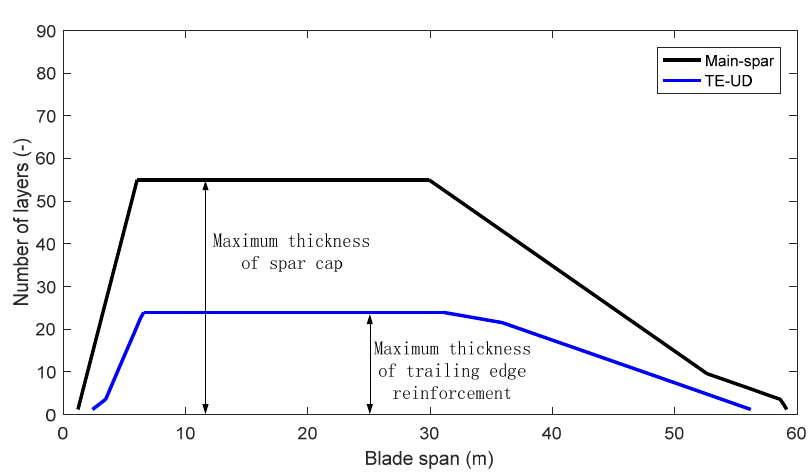
Figure 7. Design variables for spar cap and trailing edge reinforcement.